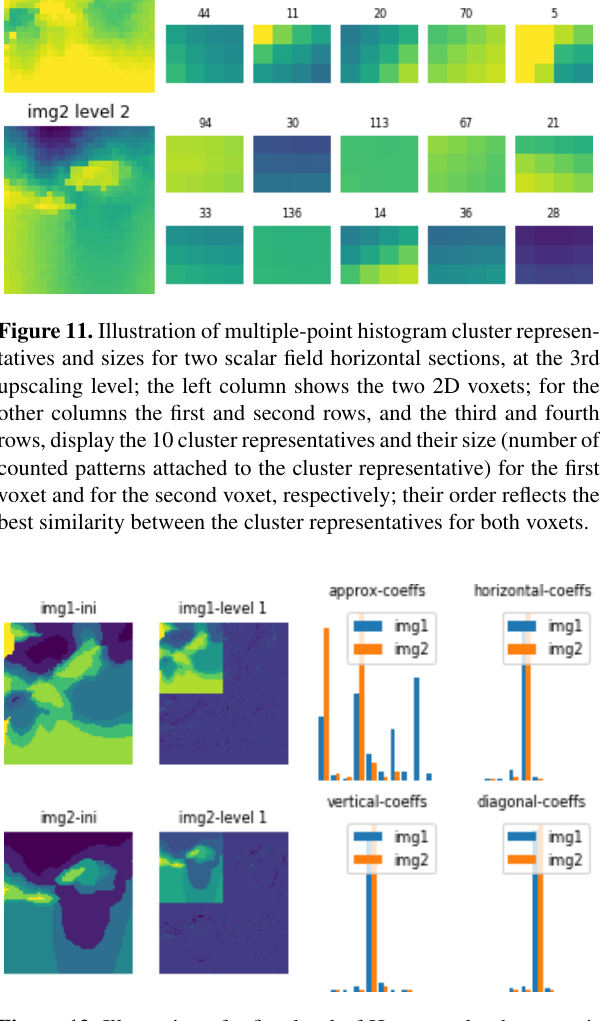
Figure 12. Illustration of a first level of Haar-wavelet decomposi- tion and the resulting coefficient histograms for two lithocode voxet horizontal